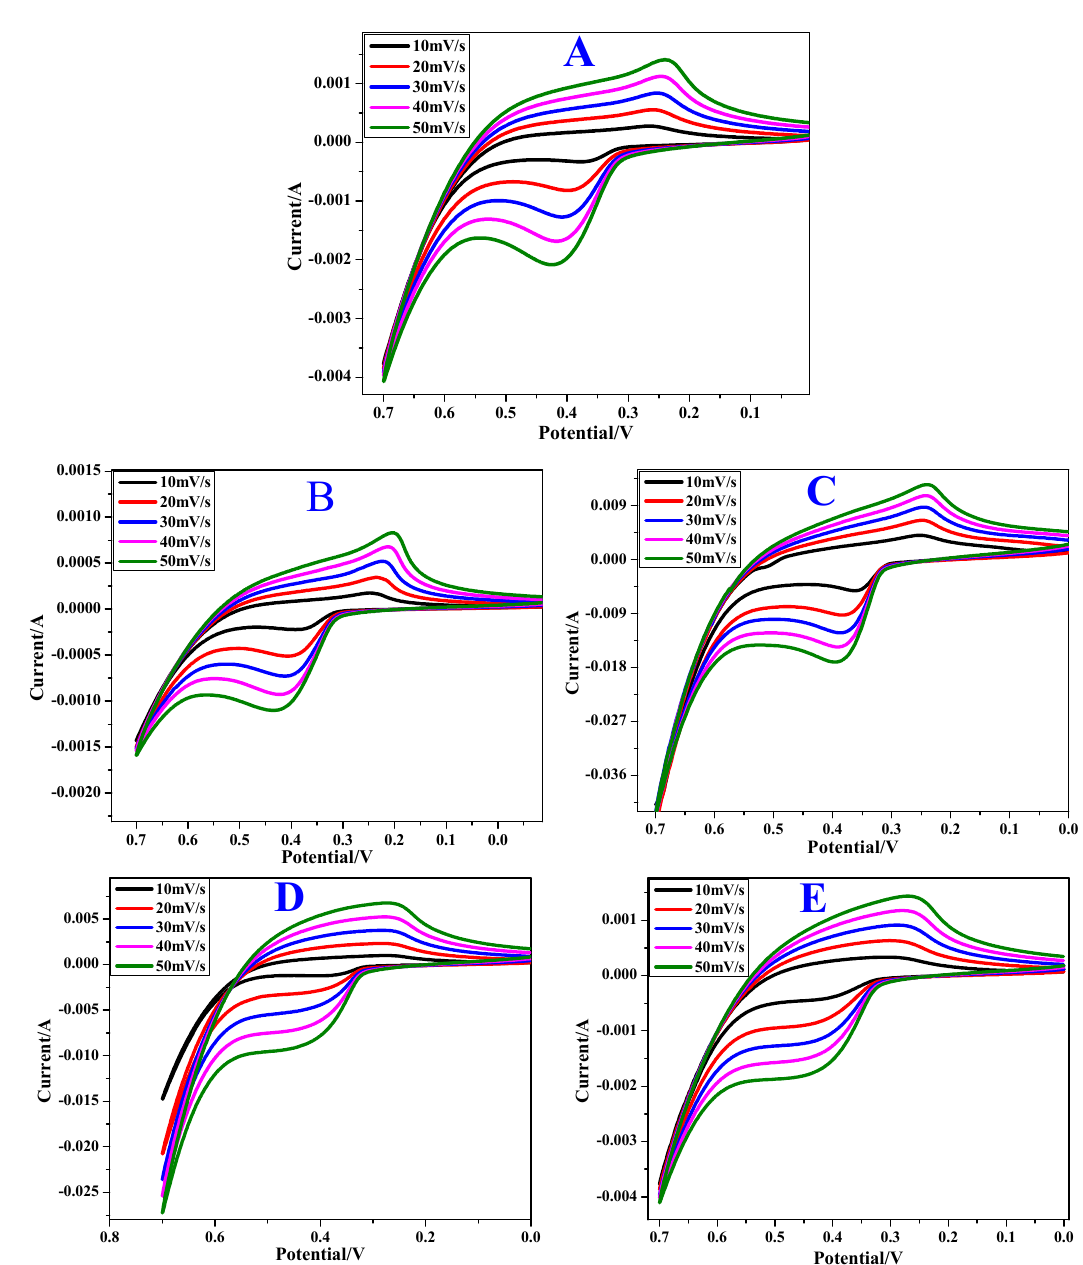
Figure 10. Cyclic voltammogram of ( A ) pristine NiO, ( B ) pristine NiO with PEG, ( C ) NiO with PEG and 1 wt% Li, ( D ) NiO with PEG and 2 wt% Li, ( E ) NiO with PEG and 5 wt% Li at various scan rates.